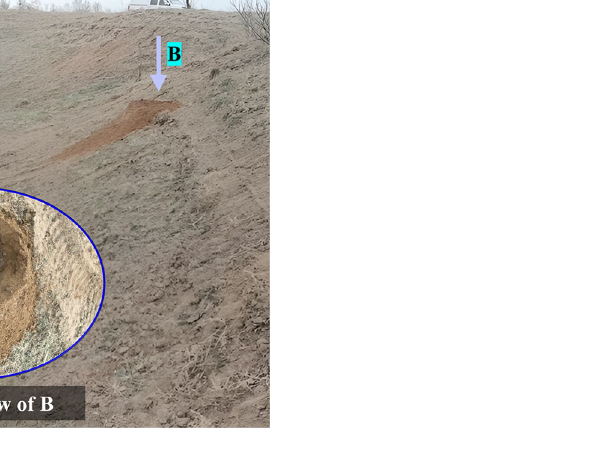
Figure 10. Operation diagram at the experiment